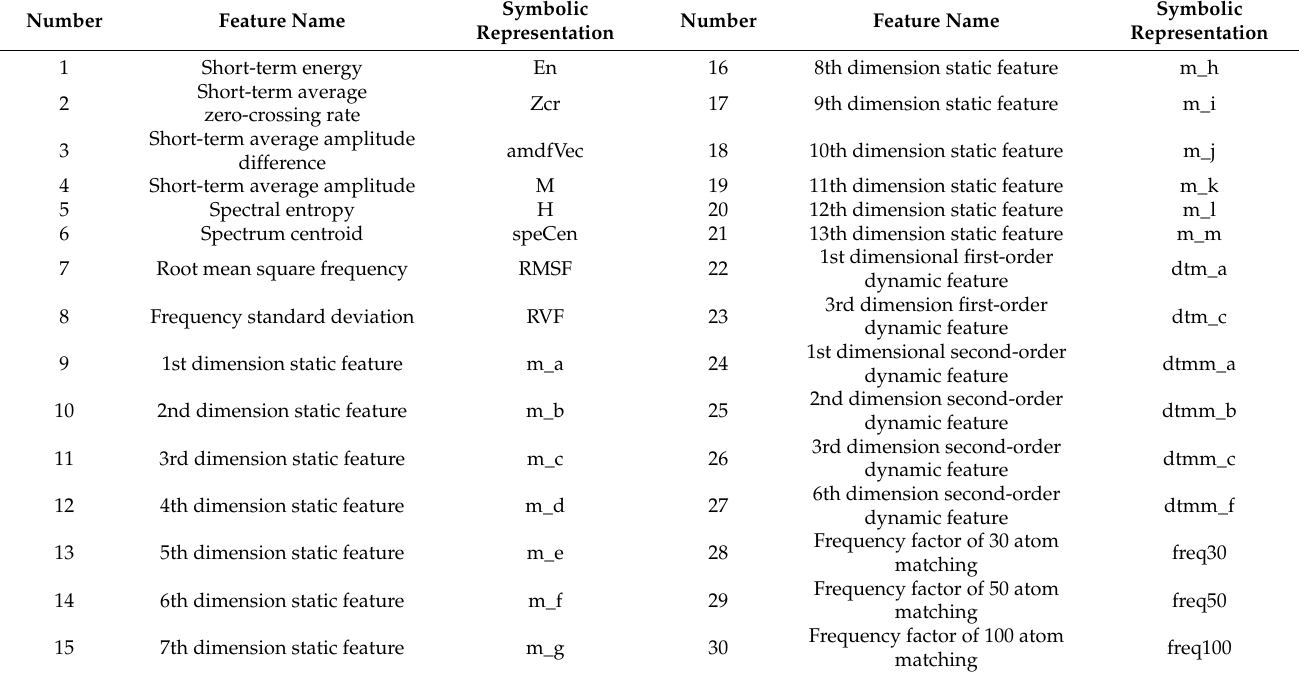
Table 4. Specific description of the retained thirty sound